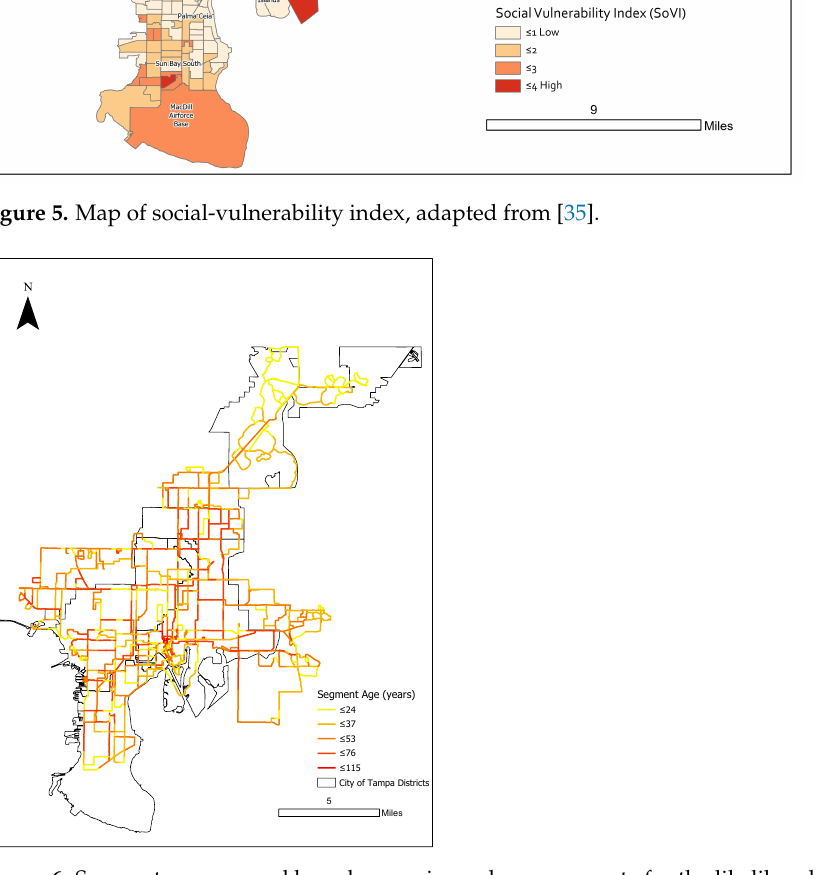
Figure 6. Segment age mapped by color; age is used as a surrogate for the likelihood of